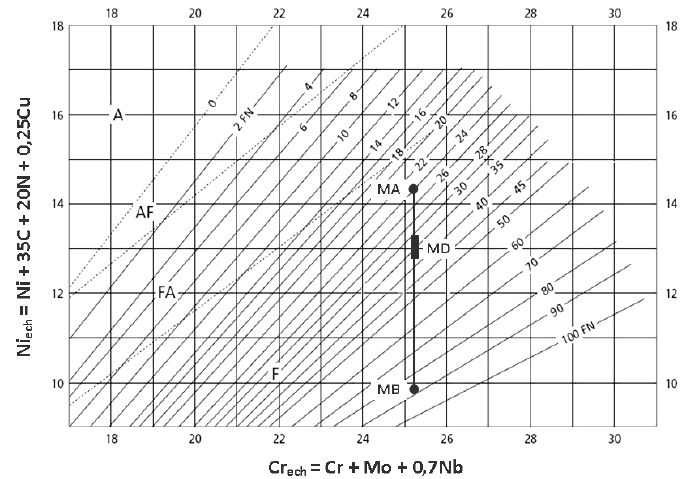
Figure 9. Ferrite diagram index with construction for ferrite index calculation.